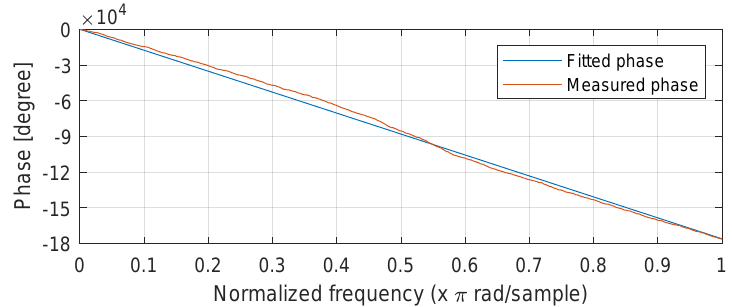
Figure 9. Phase response of one of the filters achieved with the CNN method (FIR order 1024) and a linear fitting. Frequency is normalized according to